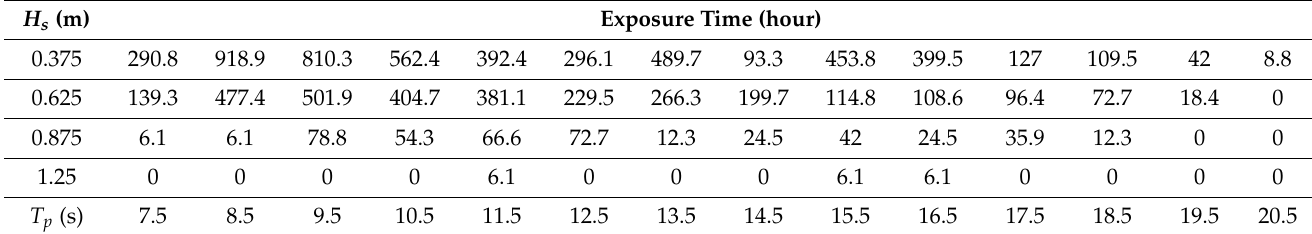
Table 5. Wave height-period distribution of the secondary swell in West Africa.